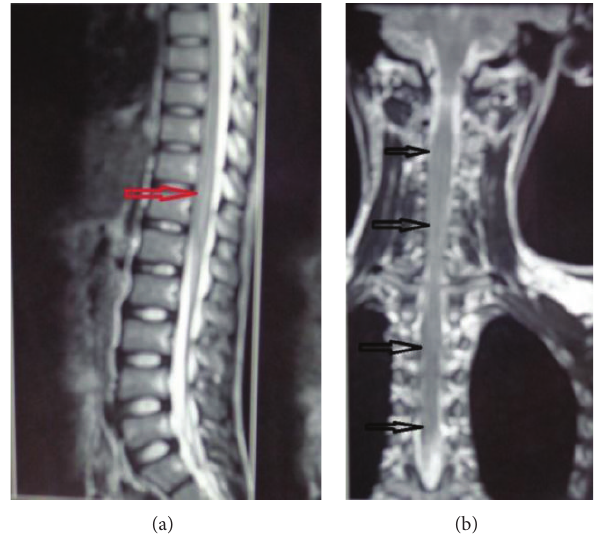
Figure 2: Spinal screening shows abnormal cord intensities in entire cord with gross edema in cervical and conus